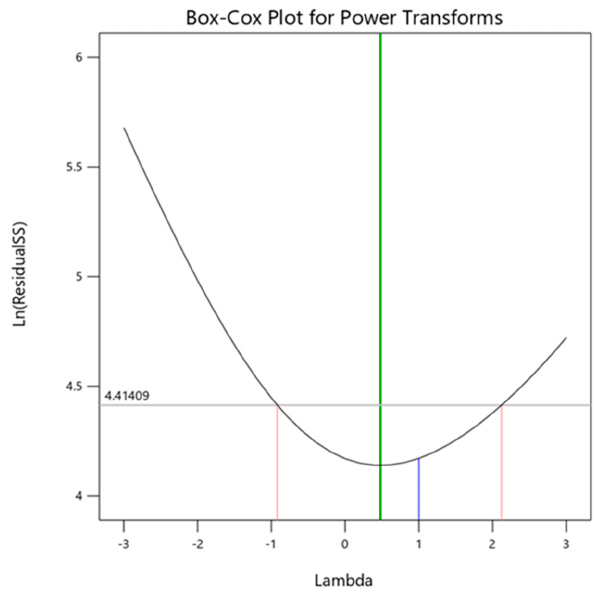
Figure 4. Transformation of model power.